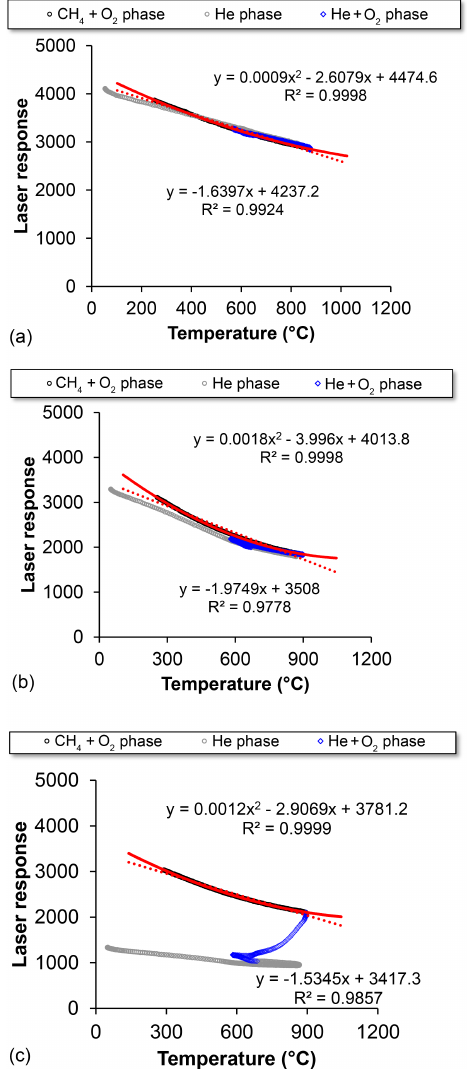
Figure A1. Correlation between laser response and temperature ( ◦ C) for the three samples whose thermograms are shown in Fig. A2. (a) blank at 00:15LT, 6 July 2012; (b) ambient sample at 20:00LT, 6 July 2012; (c) ambient sample at 06:00LT, 9 July 2012. The grey lines indicate points during the oxygen-free (He only) phase of the analysis, the blue line is for points during the oxidizing stage (He + O 2 ) of the analysis, and the black line is for the points during the calibration stage (CH 4 + O 2 ). The red line is a best-fit polynomial through the CH 4 + O 2 points, while the dashed red lines are linear